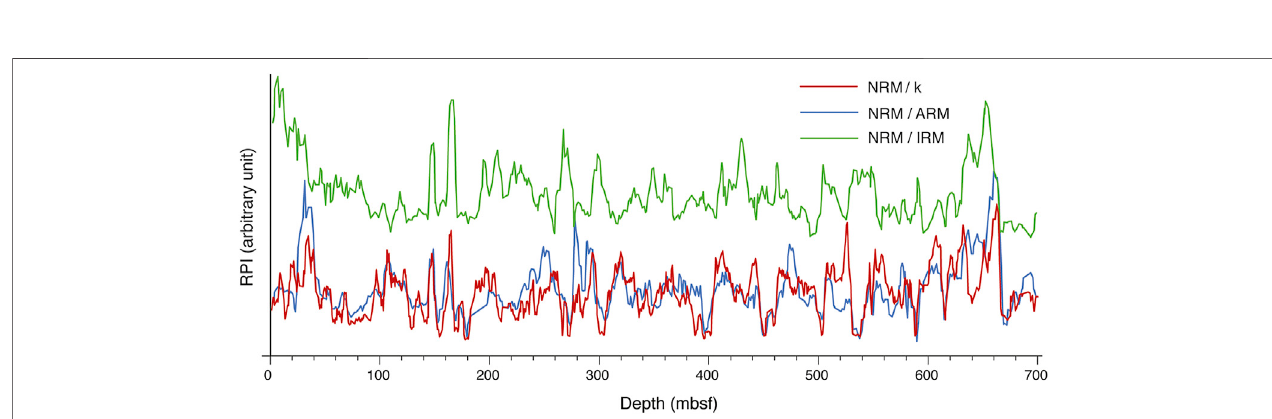
FIGURE 6 | Comparison between the three RPI proxies (NRM/k, NRM/ARM, NRM/IRM) plotted versus depth.